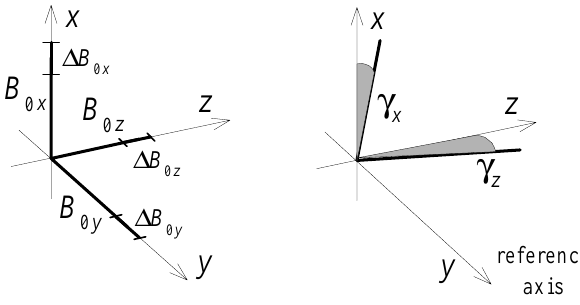
Fig. 7. Schematic representation of the offset and alignment of the FGM sensor axes. Values of the offsets and the measured values of the misalignment are given in Table 4.